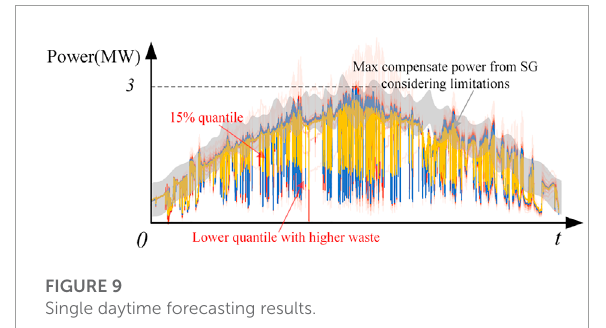
FIGURE 9 Single daytime forecasting results.